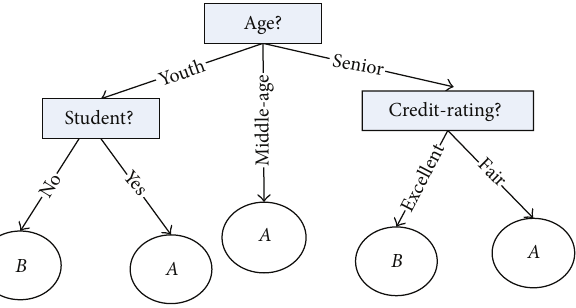
Figure 1: Framework of the proposed model.